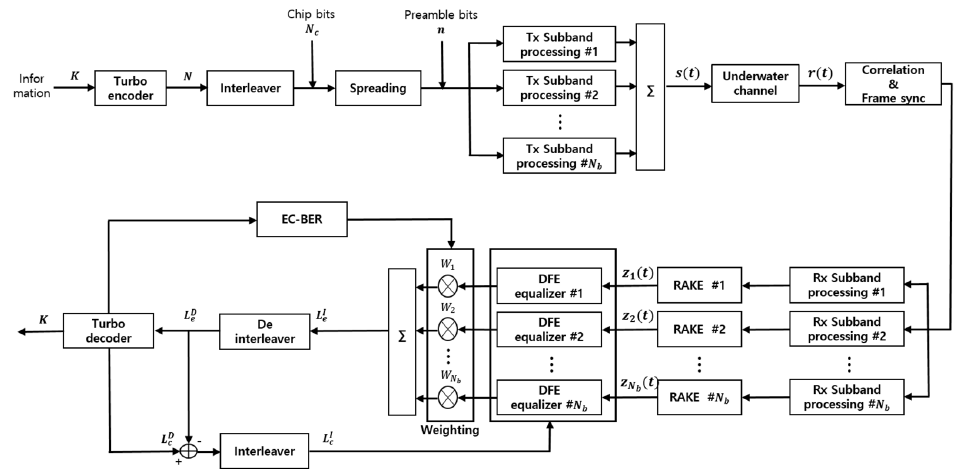
Figure 1. The structure of the multi-band FSK transceiver model with a DSSS.